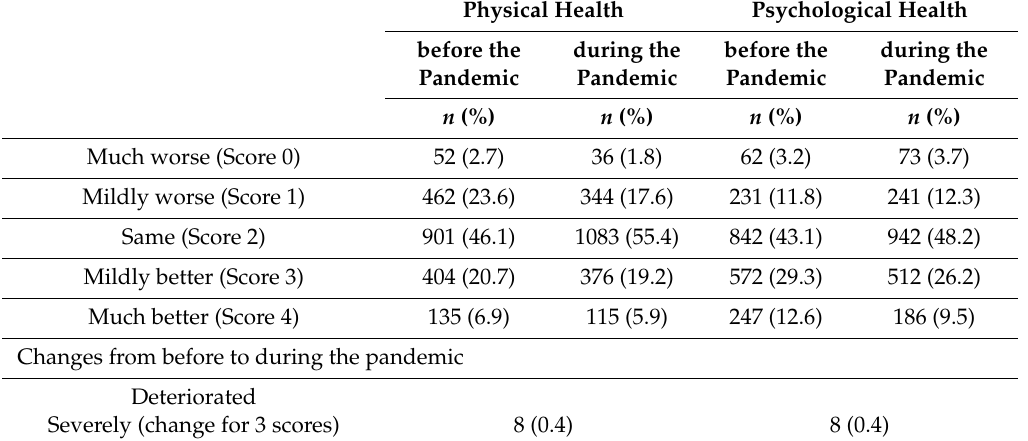
Table 1. Subjective physical and psychological health before and during the coronavirus disease 2019 (COVID-19) pandemic (N = 1954). Much worse (Score 0) 52 (2.7) 36 (1.8) 62 (3.2) 73